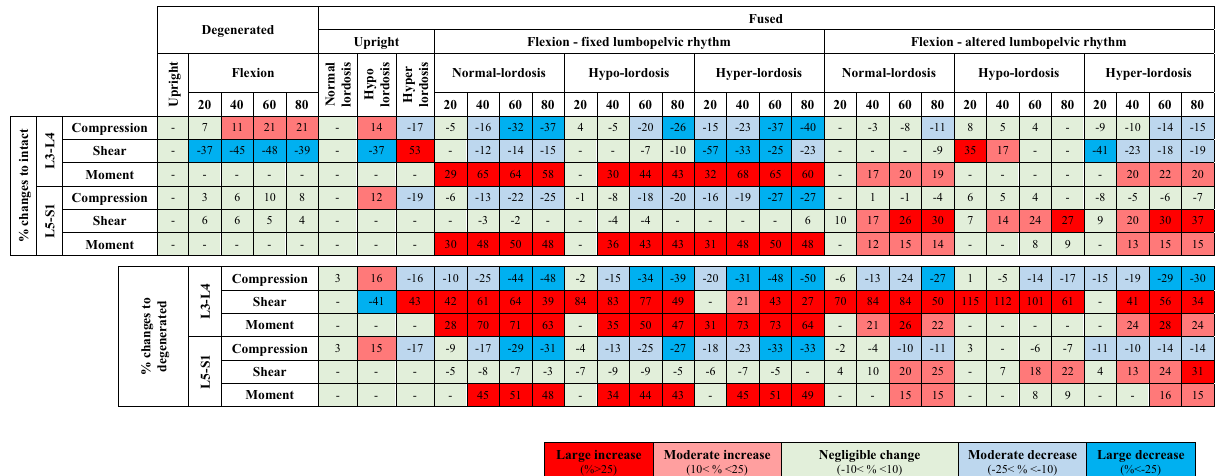
Table 1. Changes (%) in adjacent segment compression and shear loads as well as passive moment in fused/ degenerated states relative to intact state (upper section) and in fused states relative to degenerated state (lower section) in upright and flexed postures. Magnitude of changes is depicted by five color-coded levels (see the legend below). Small net changes (e.g., less than 2 Nm for passive moments or 10 N for compression and shear forces) are marked with (-) irrespective of their relative